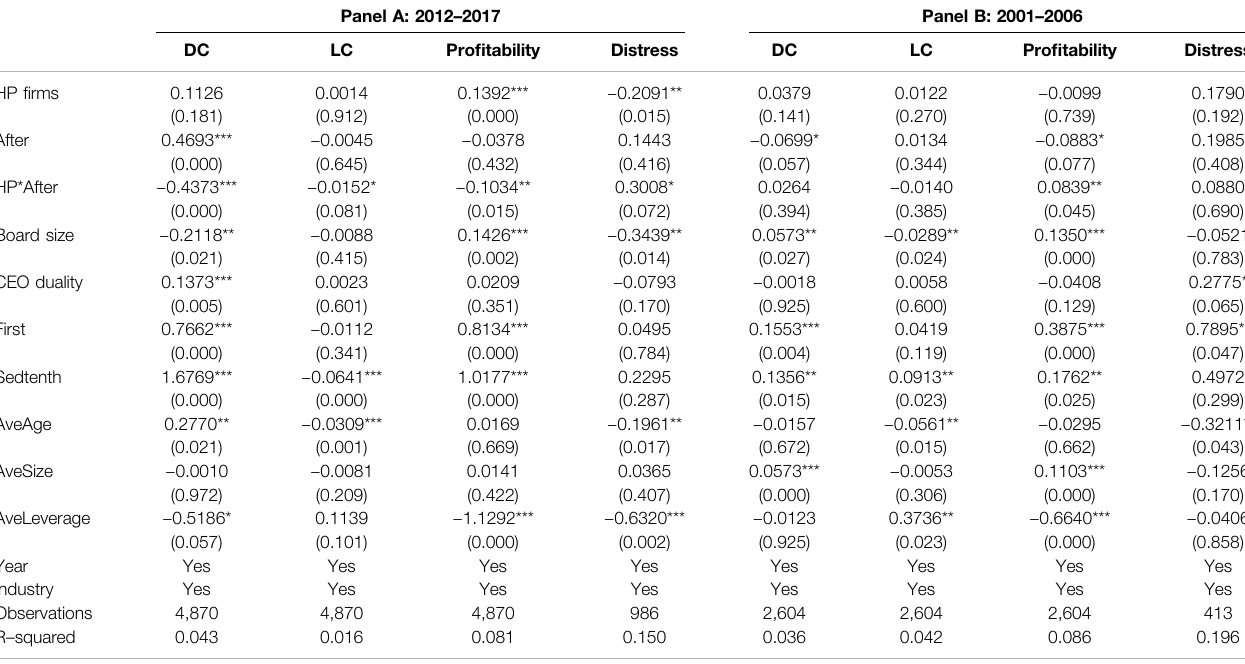
TABLE 8 | Endogeneity test – sector average. This table presents the results of endogeneity test – sector average. We utilize sector-level variables (AveAge, AveSize, and AveLeverage) to replace fi rm-level variables andrepeatourempiricalanalyses.Fortheprobitregression(columnDistress),wereportthemarginaleffectratherthanthecoef fi cients.Forthede fi nitionsofvariablesreferto Appendix A . P -values are in